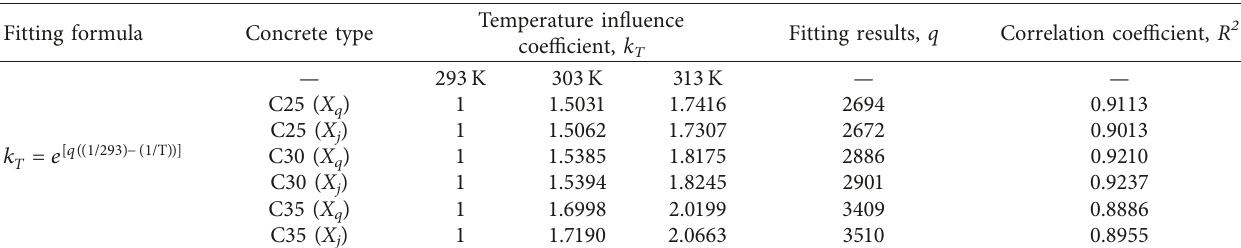
Table 3: Results of the values of fitting coefficient ( q ).